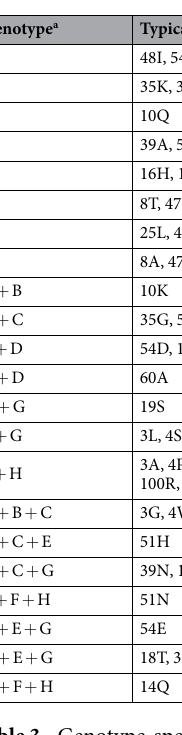
Table 3. Genotype-specific amino acid variants in PreS1 region. a The viral genotype(s) and their specific PreS1 amino acid residues are listed. Only genotype-specific variants in three or less genotypes are showed. b The genotype-specific amino acid variants are represented by their positions on PreS1 peptide (from 1st to 119th residues) and the amino acid